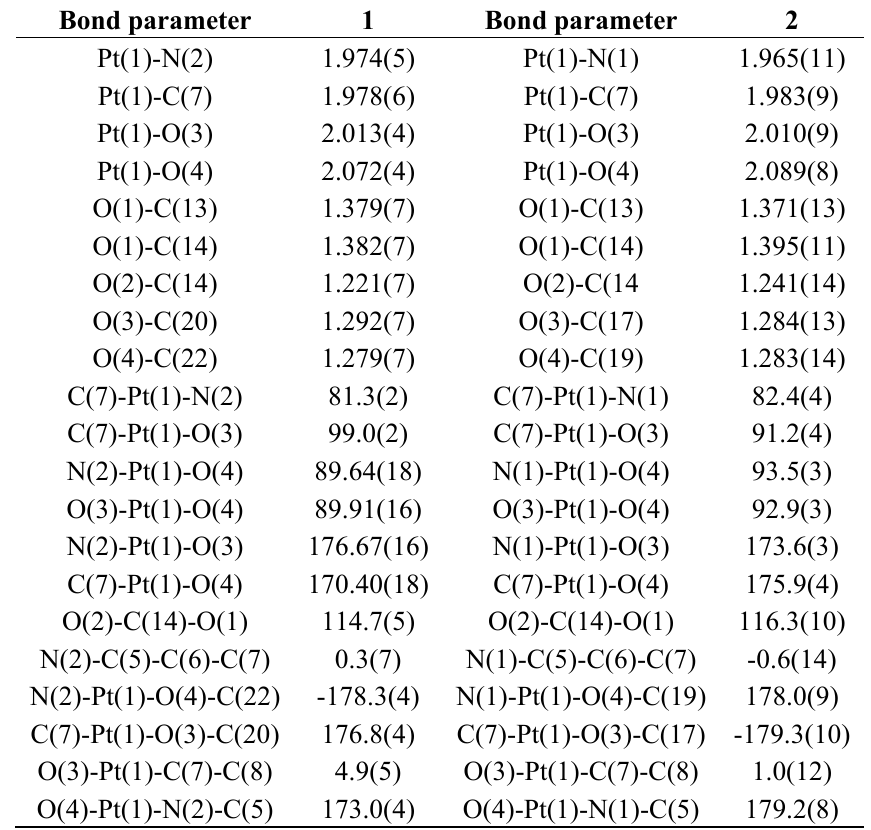
Table 1. Selected bond lengths [Å], bond angles [deg], and dihedral angles [deg] for complexes 1 and 2